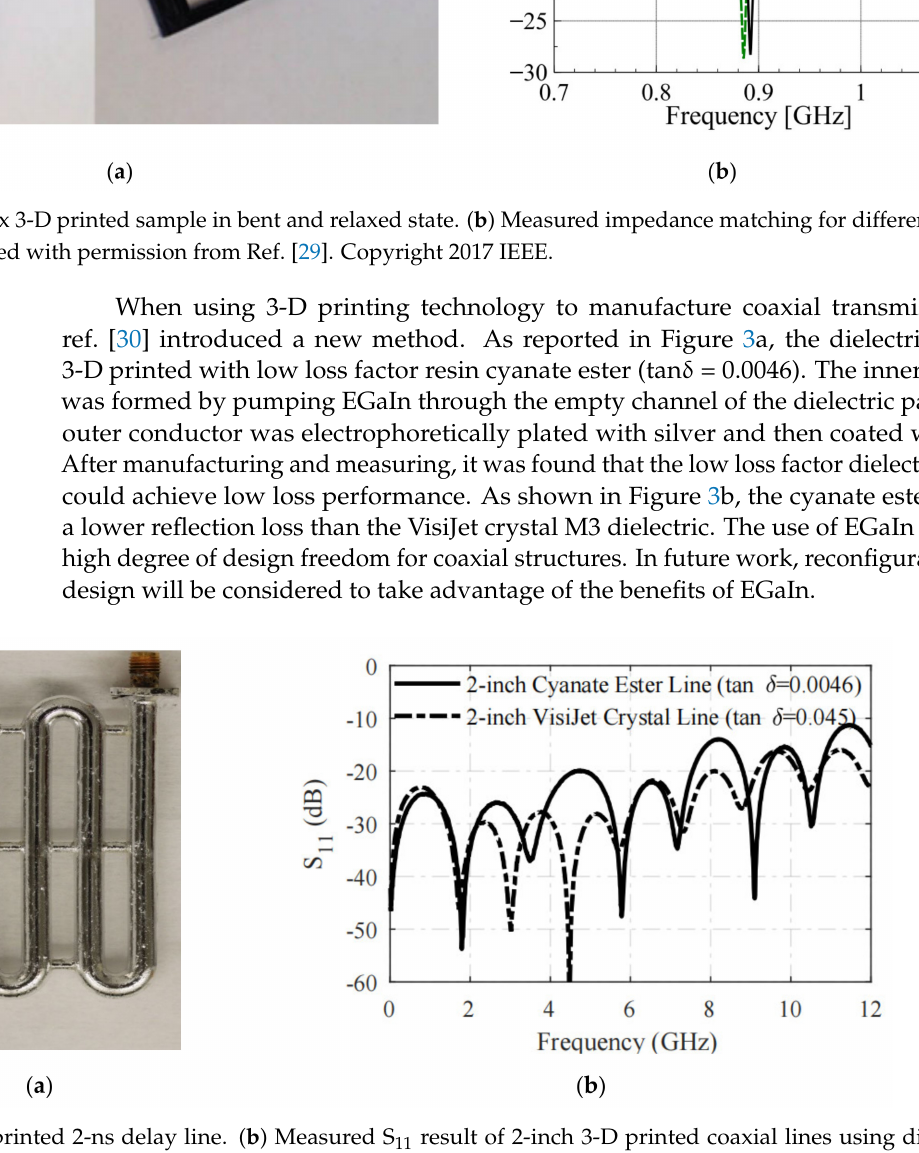
Figure 3. ( a ) A 3-D printed 2-ns delay line. ( b ) Measured S 11 result of 2-inch 3-D printed coaxial lines using different dielectric material. Reprinted with permission from Ref. [30]. Copyright 2018